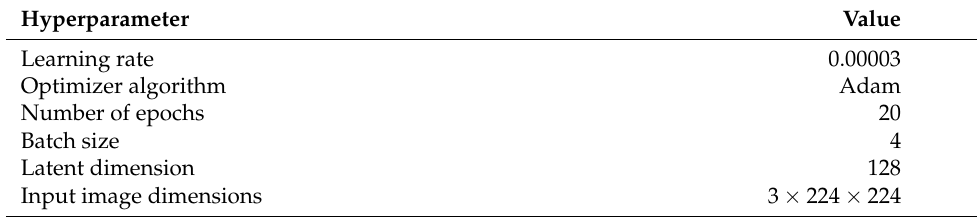
Table 4. Selected hyperparameters for EVAE-Net.